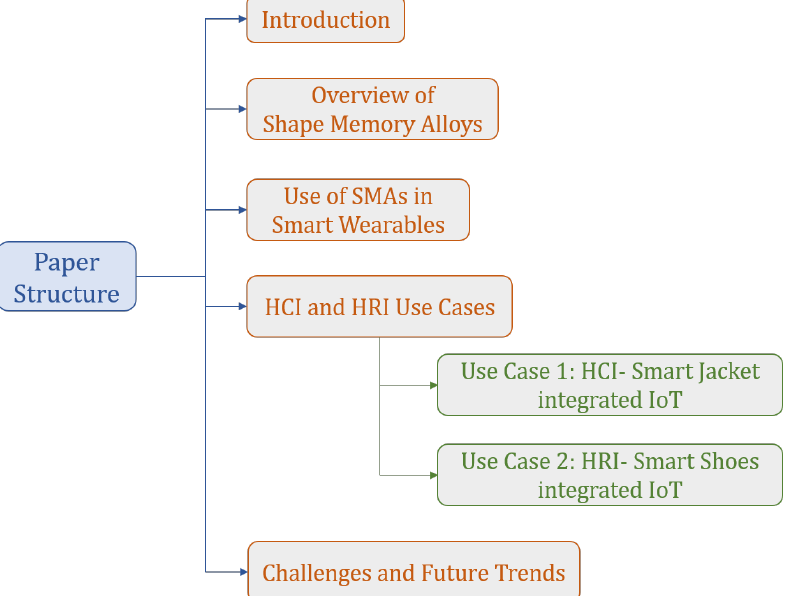
Figure 1. Paper Structure. The importance of adding smart wearables to IoT is discussed in Section